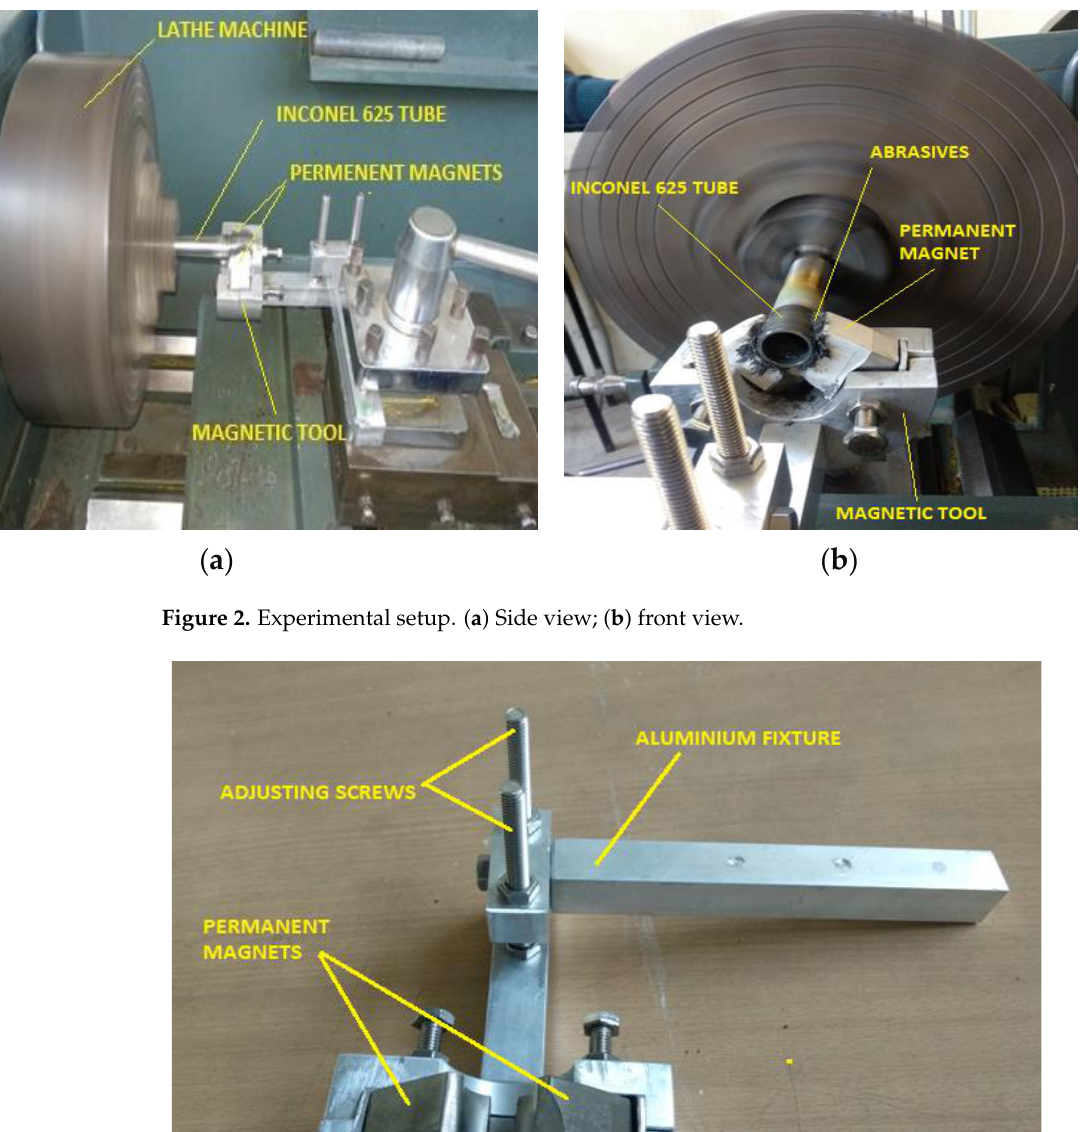
Figure 3. Magnetic tool.